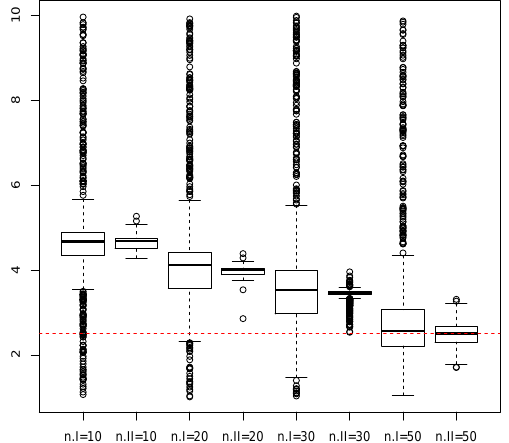
Figure 5. The boxplots of 1000 Bayes estimates of c , where “n.I” and “n.II” indicate that procedures BE-I and BE-II are implemented with sample size n ,